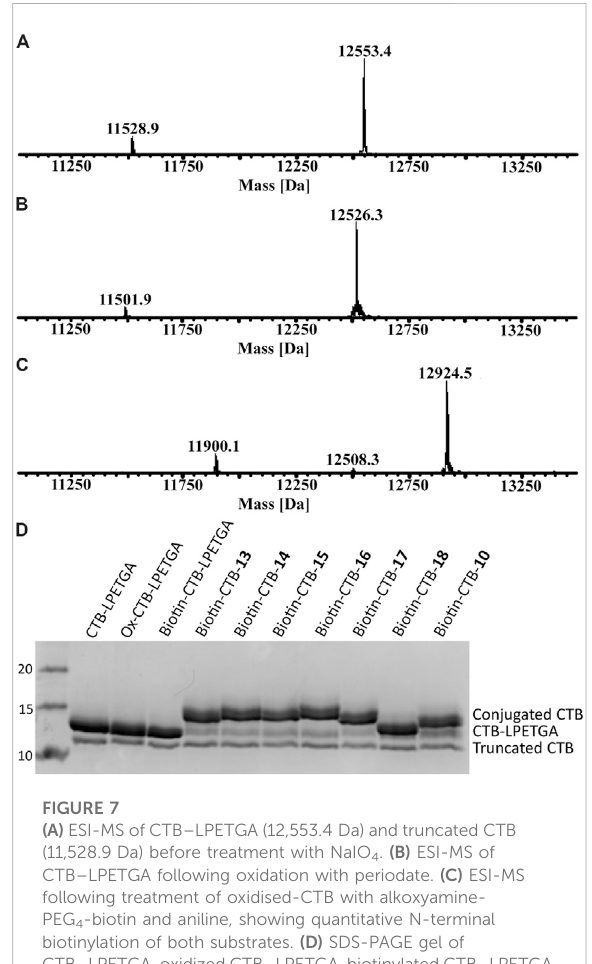
FIGURE 7 (A) ESI-MS of CTB – LPETGA (12,553.4 Da) and truncated CTB (11,528.9 Da) before treatment with NaIO 4 . (B) ESI-MS of CTB – LPETGA following oxidation with periodate. (C) ESI-MS following treatment of oxidised-CTB with alkoxyamine- PEG 4 -biotin and aniline, showing quantitative